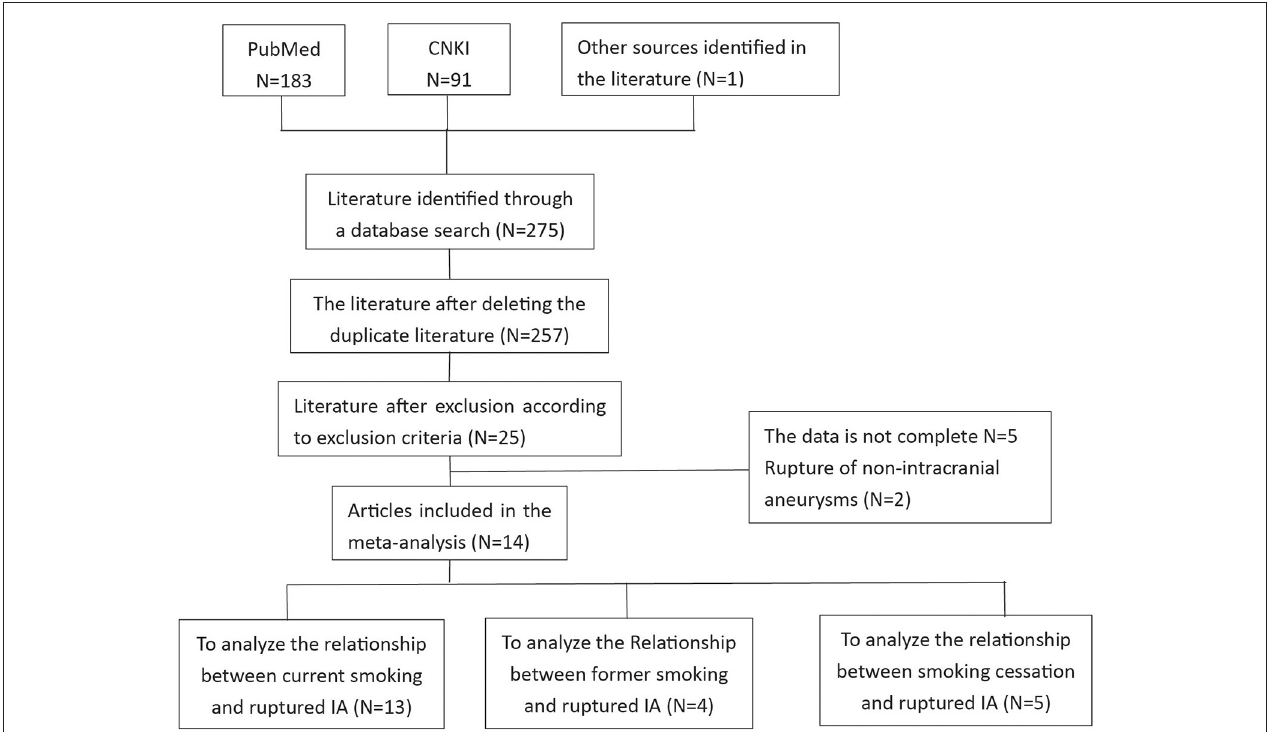
FIGURE 1 | A flow chart of literature selection.